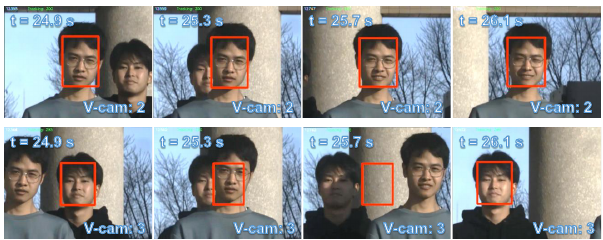
Figure 19. Cross-tracking of person 2 and person 3 between 24.9 and 26.1 s.